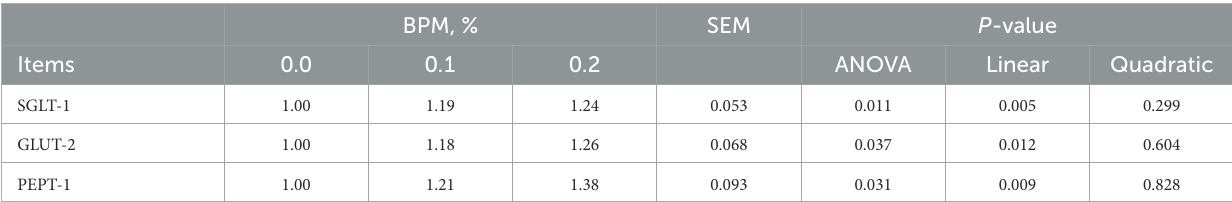
TABLE 8 Effect of dietary supplementation of Bacillus subtilis and Pichia farinose mixture (BPM) on jejunal nutrient transporter gene expression of broiler chicks ∗ . BPM, % SEM P